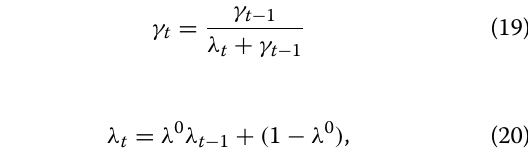
variance σ 2 is preferable to be taken bigger than needed t